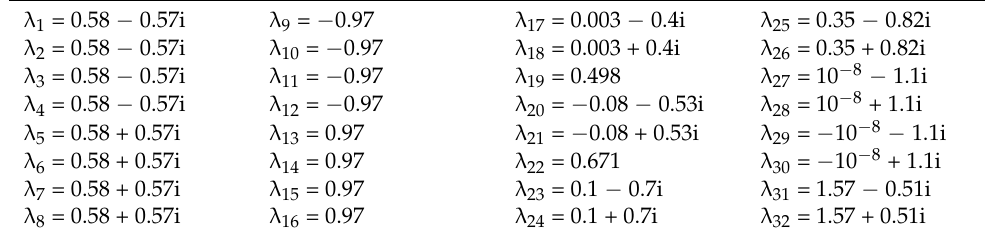
Table 7. Roots of the polynomial.